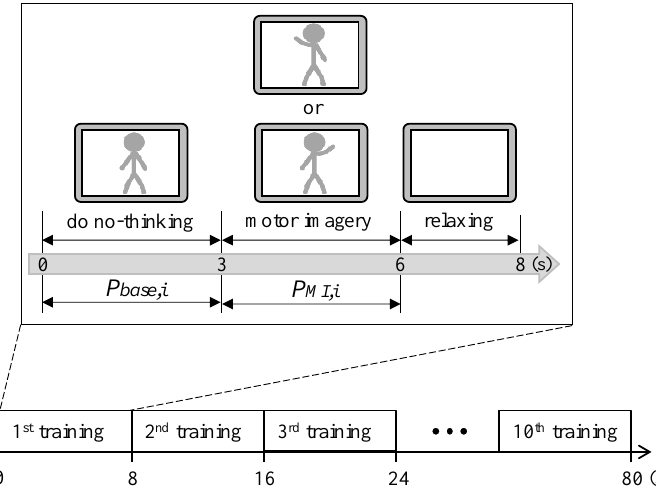
Figure 4. Illustration of the procedure of channel selection algorithm.